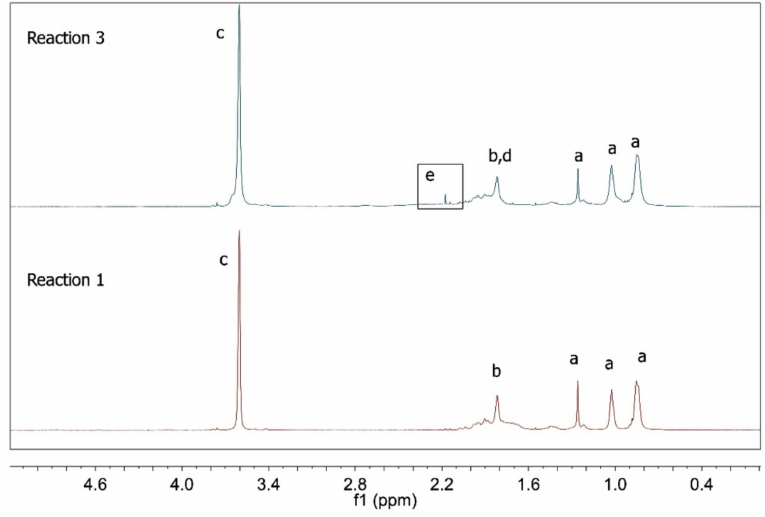
Figure 6. 1 H NMR spectra of polymer products of R1 and